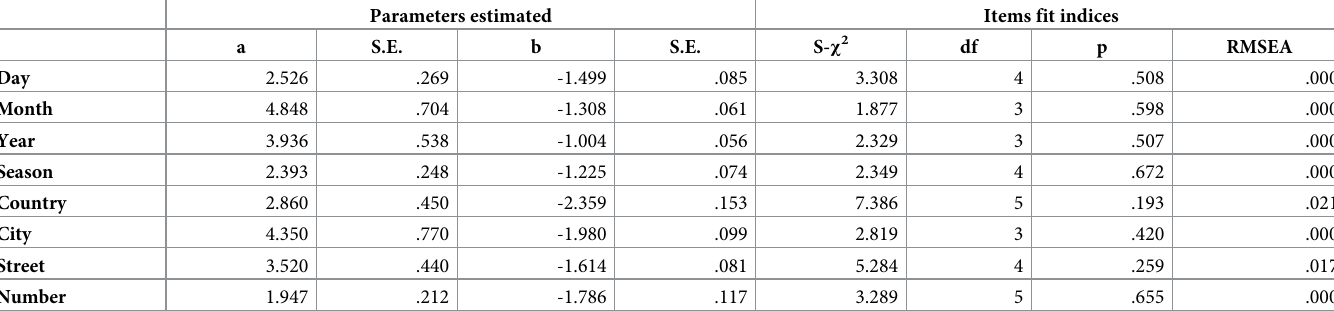
Table 2. Parameters estimated and item fit indices of proposed version of orientation dimension. Parameters